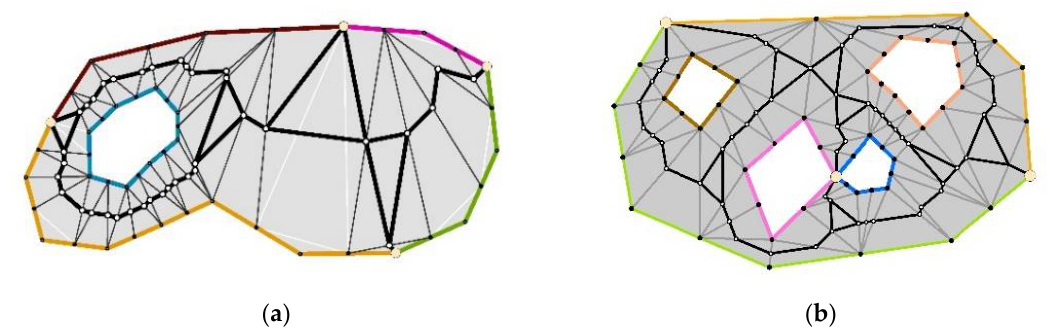
Figure 10. Skeletons generated by the BPSplit algorithm based on the spatial data presented in Figure 9: ( a ) skeleton of a polygon with a single hole; ( b ) skeleton of a polygon with four holes.